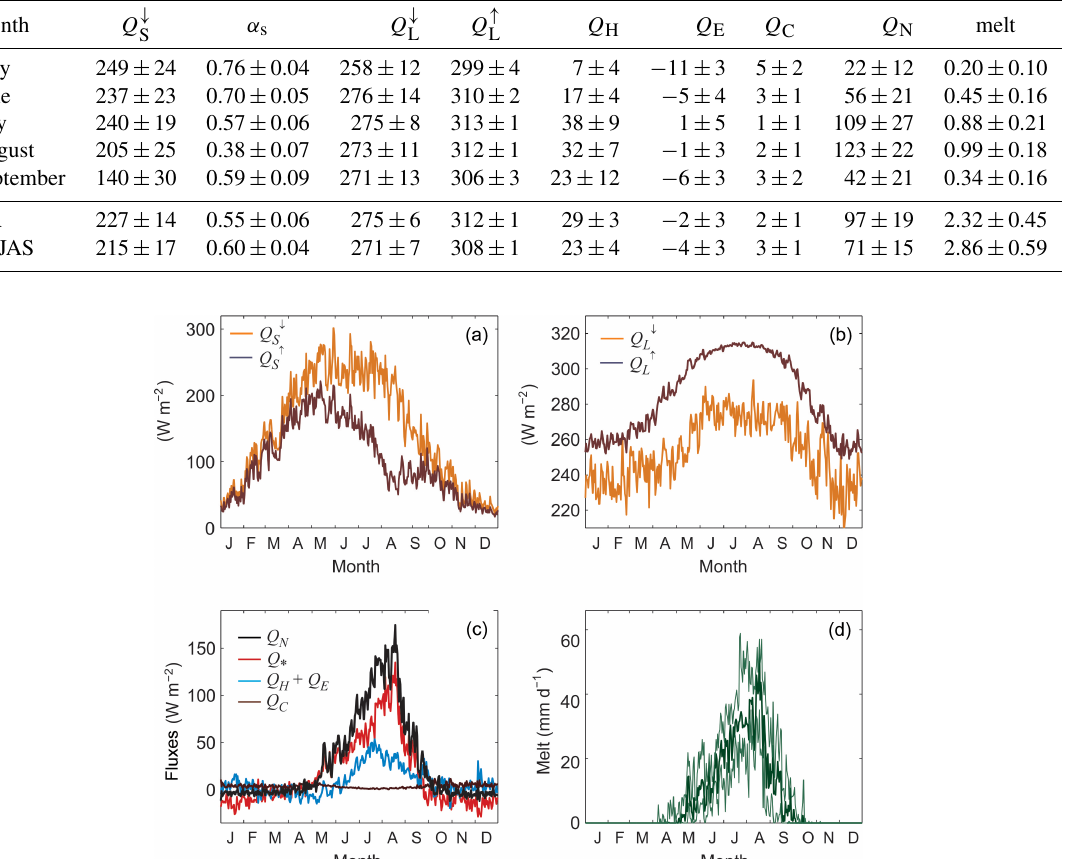
Table 2. Mean monthly surface energy balance terms ± 1SD at Haig Glacier, Canadian Rocky Mountains, May to September 2002–2012. Radiation fluxes and albedo values are from automatic weather station measurements and the turbulent fluxes and subsurface heat conduction are modelled from the AWS data. Fluxes are in Wm − 2 and melt totals are in mw.e.